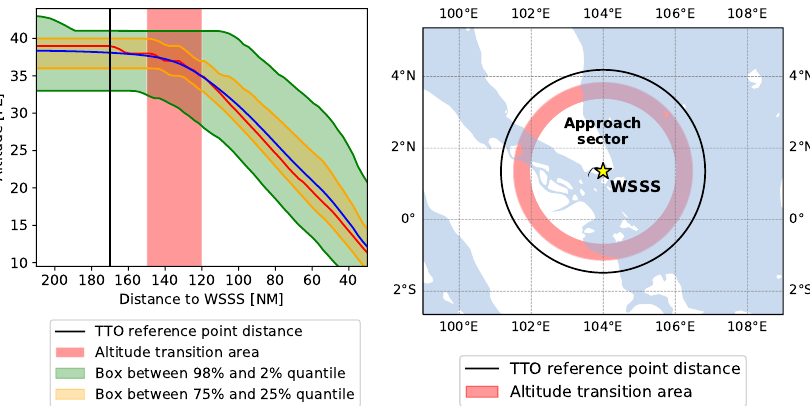
Figure 3. Left : TTO reference point distance to WSSS. Right : Lateral view of the approach sector (170 NM around WSSS).